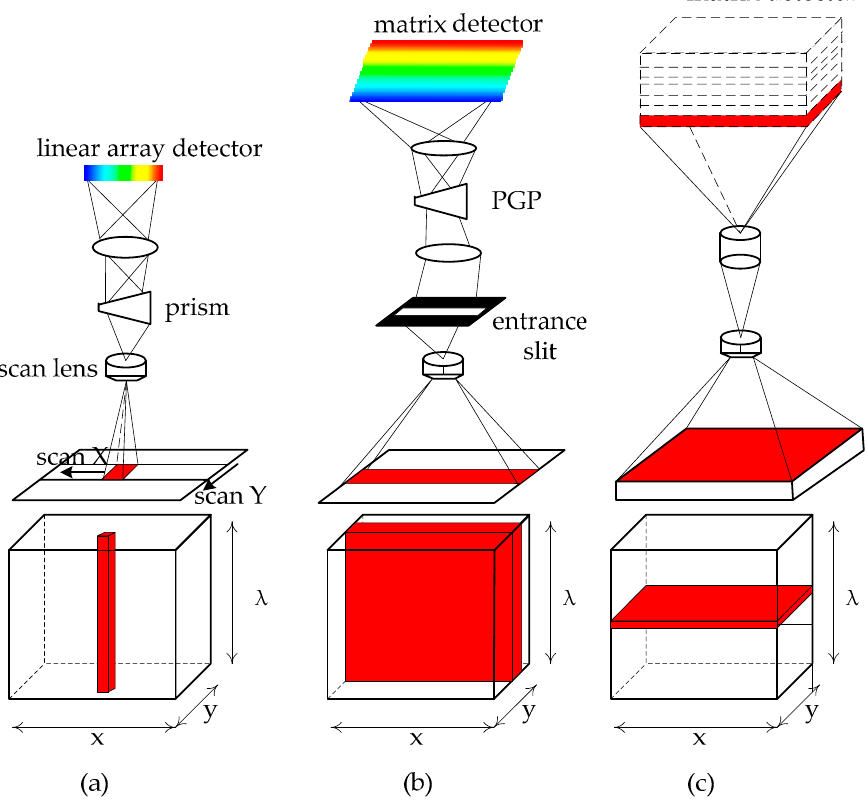
Figure 3. Typical spectral imaging methods. ( a ) Whiskbroom. ( b ) Push broom. ( c ) Staring.